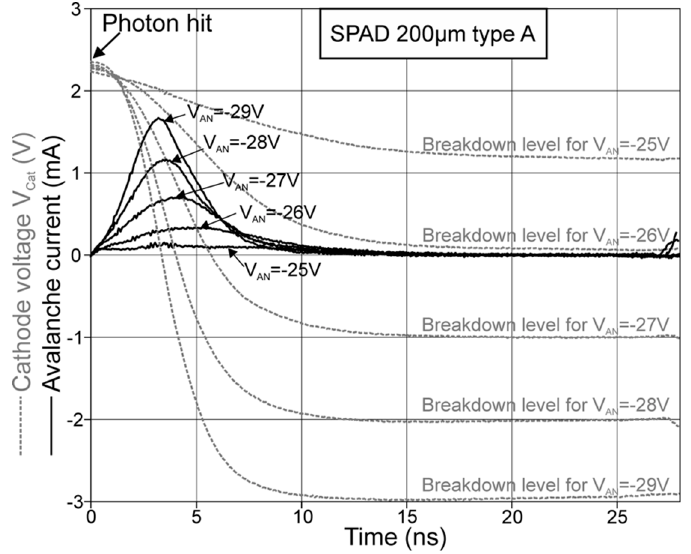
Figure 8. Avalanche-current transients for a SPAD type A with 200 µm diameter for different anode voltages V AN , where the avalanche starts at 0 ns.